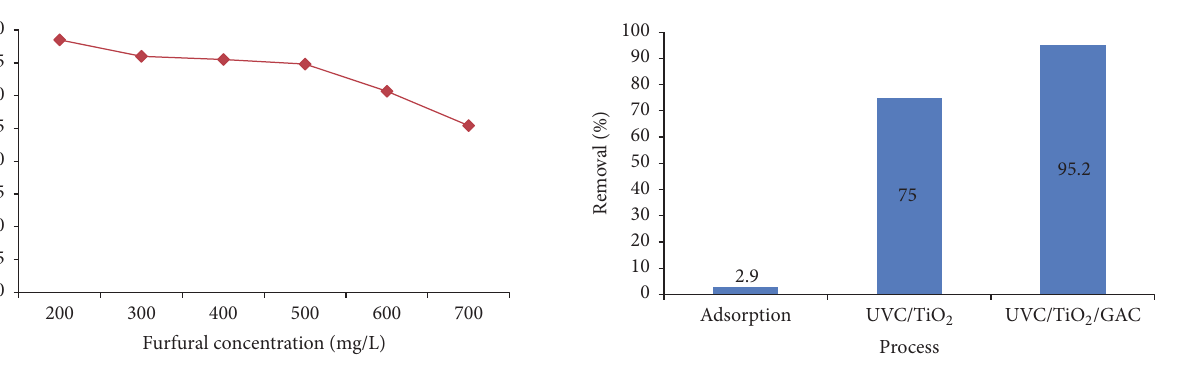
Figure 9: Comparison of the furfural removal efficiency in adsorp- tion, UVC/TiO 2 , and UVC/TiO 2 /GAC processes at the same oper- ational conditions irradiation, time = 80 min, photocatalyst dosage = 2.5 g/L, initial furfural concentration = 500 mg/L, and initial pH =